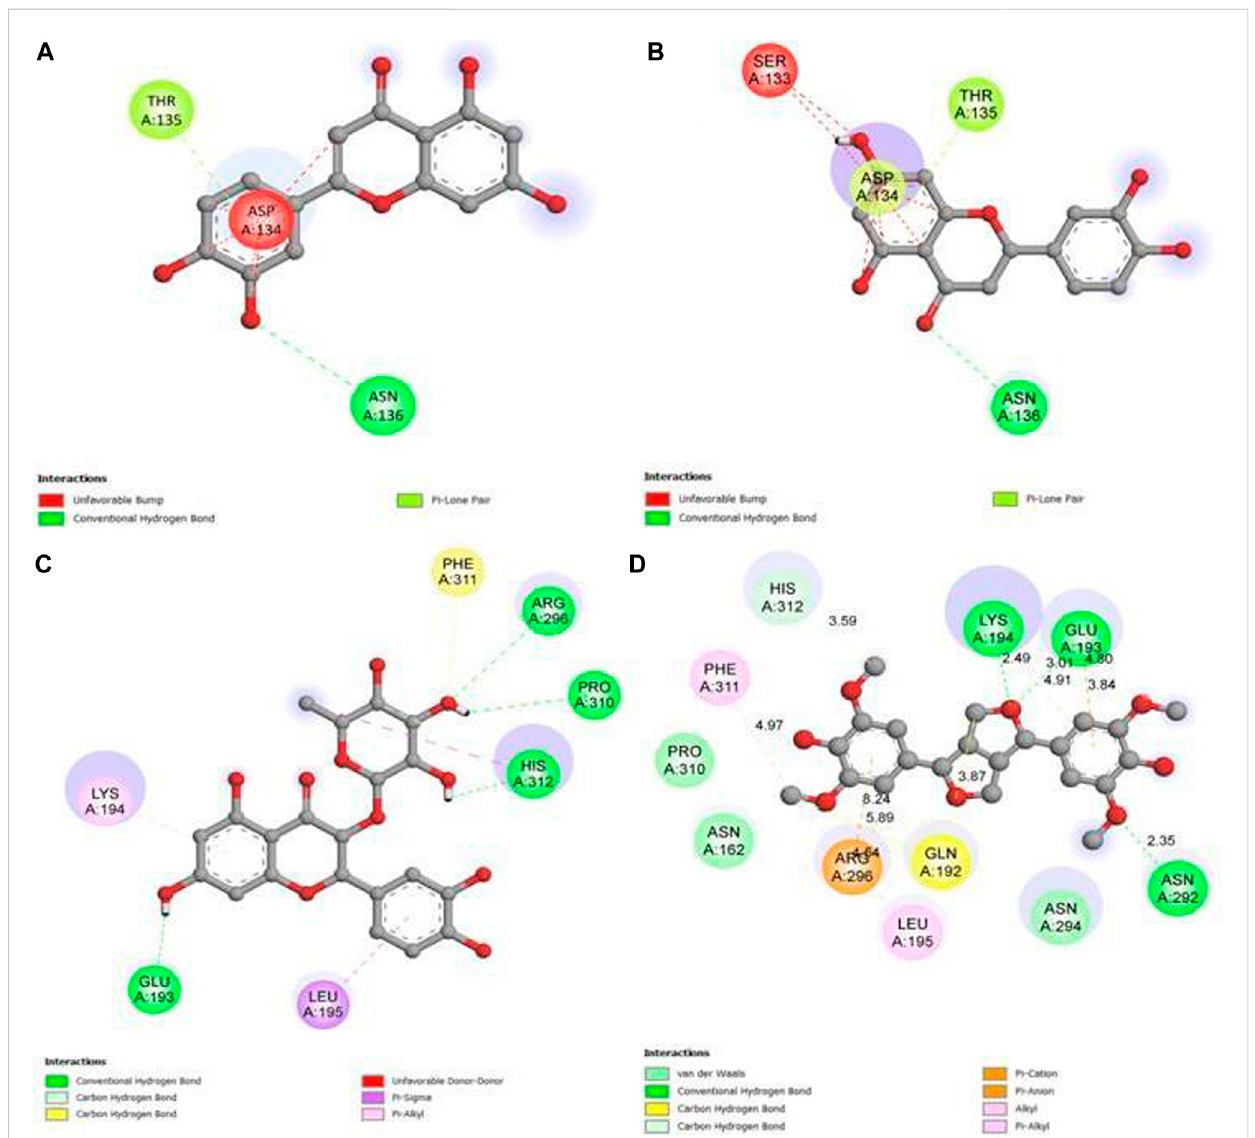
FIGURE 11 2D graph showing interactions at the molecular level for (A) pocket residues linked to luteolin, (B) pocket residues linked to eriodictyol, (C) pocket residues linked to astilbin, and (D) pocket residues linked to syringaresinol.